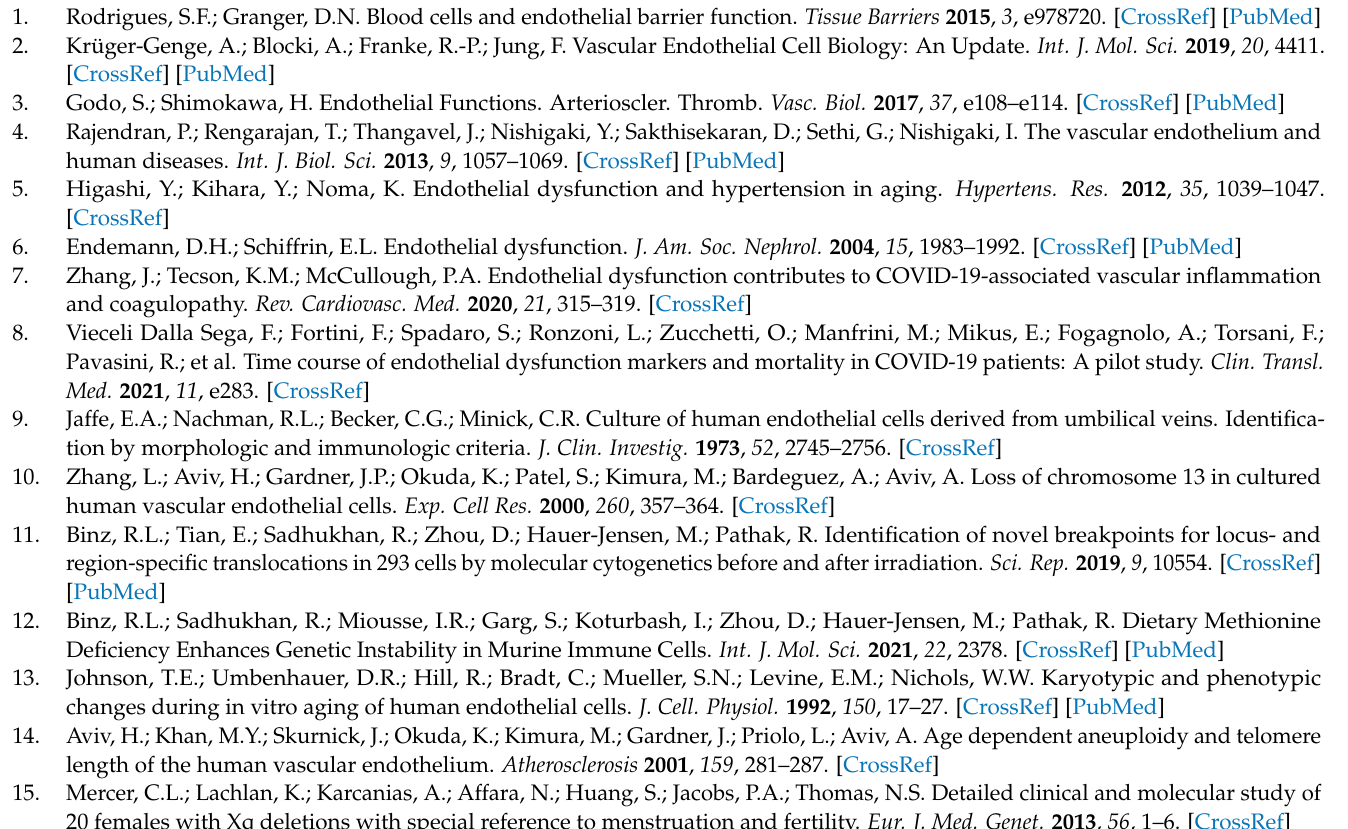
Figure S3: Comparison of 15 classified SKY cells with subsequent hybridization using ToTelVysion mix 2 showing a normal Xq ter; Figure S4: Comparison of 15 classified SKY cells with subsequent hybridization with ToTelVysion mix 2 showing a deletion of one Xq homologue in each